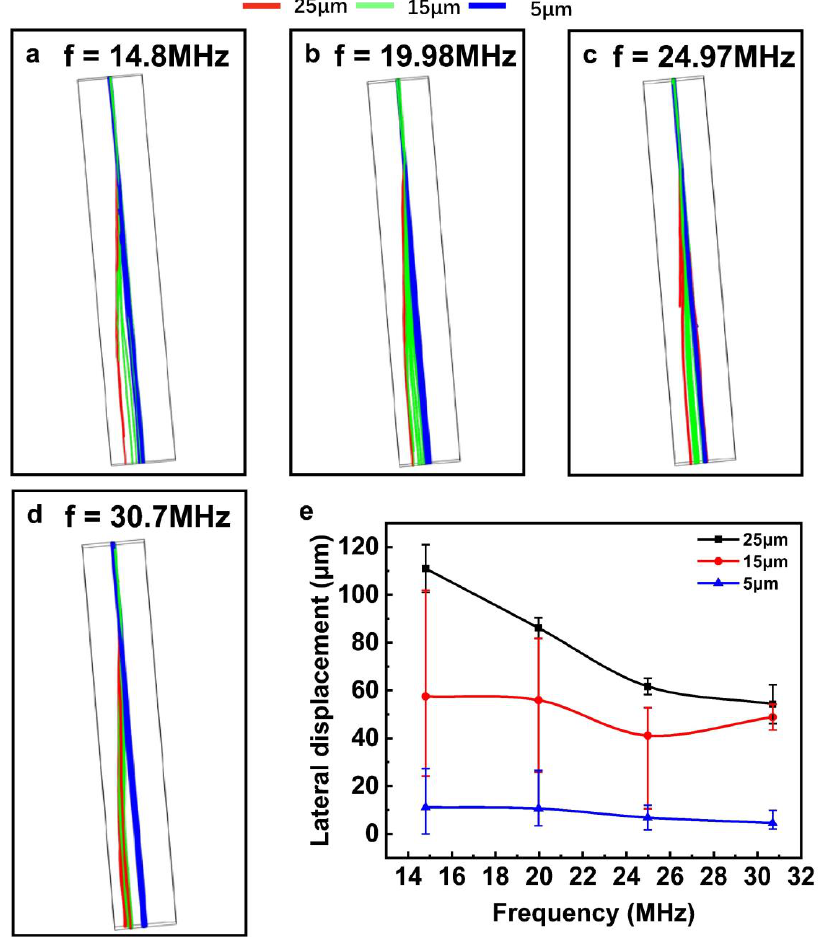
Figure 8. Flow trajectories of particles with different resonant frequencies ( a – d ) (14.8 MHz, 19.98 MHz, 24.975 MHz, 30.7 MHz); the lateral displacement summary of the particles under various driving frequencies ( e